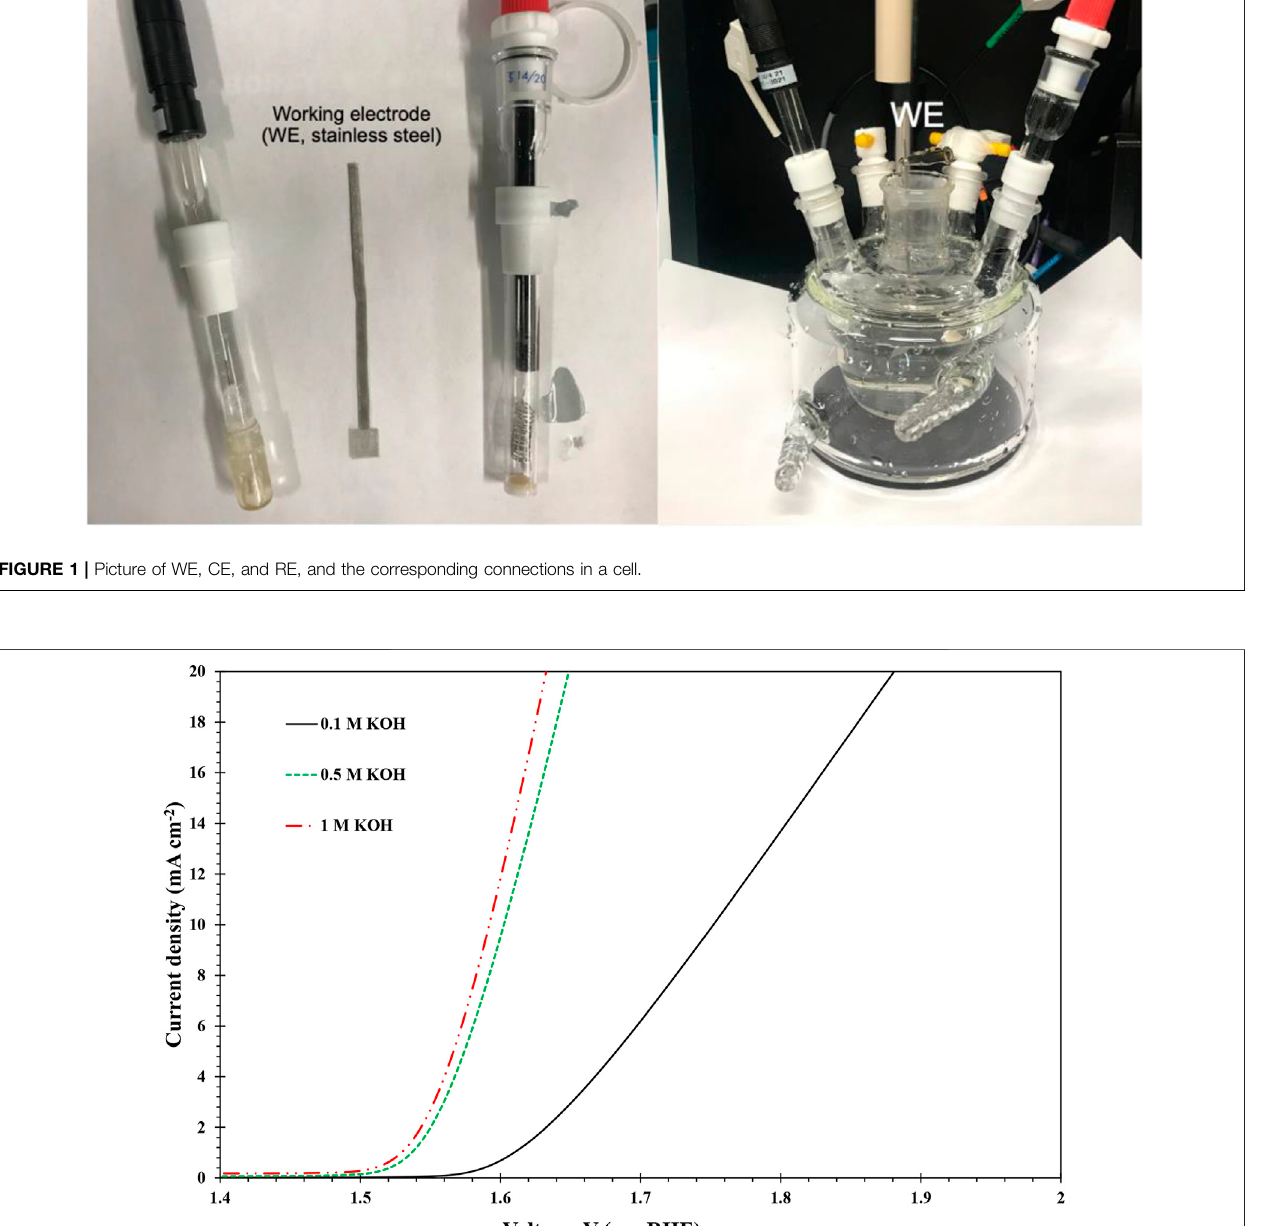
Figure 1 . Measure the geometric area of the working electrode that is exposed to the electrolyte (1 cm × 1 cm is recommended).